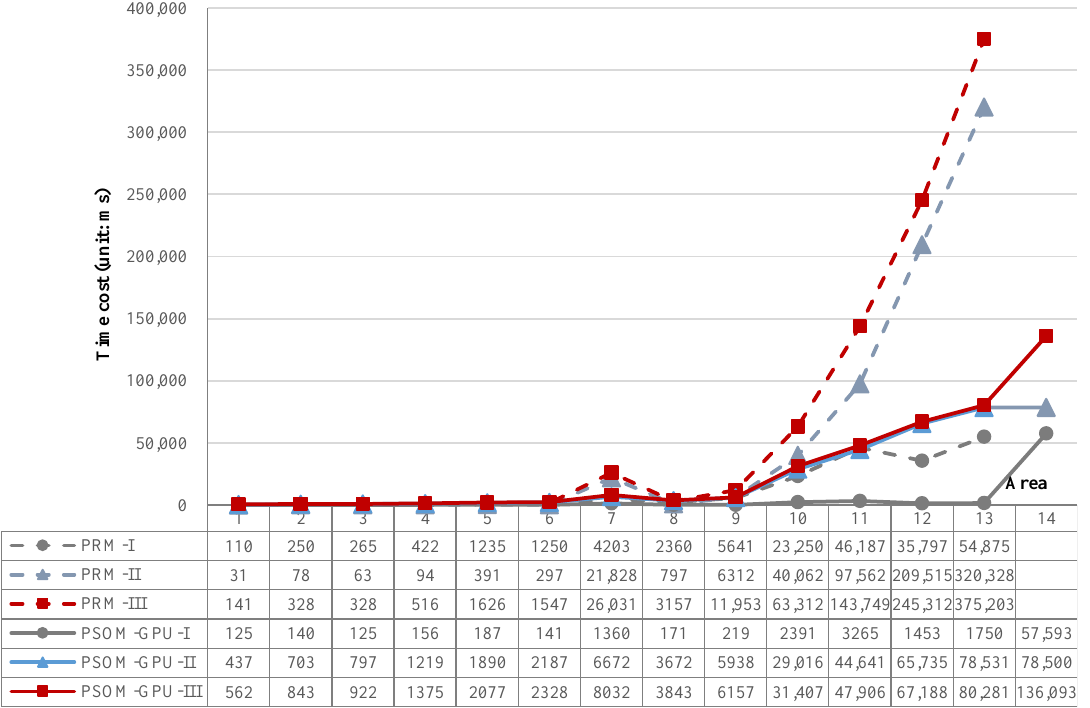
Figure 9. The time cost of PRM and PSOM-GPU for road network matching. PRM-I, -II and -III denote the similarity computation, the matching-relationship identification and the global process, respectively, using PRM. PSOM-GPU-I, -II and -III denote the same three aspects, respectively, using PSOM-GPU.